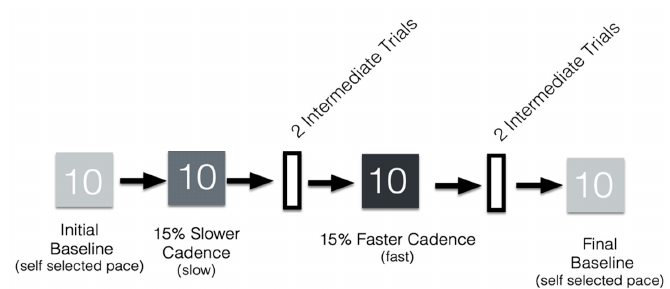
Figure 1. Metronome walking task procedure. The figure shows an example in which the slow metronome pace was played first. Light gray boxes represent initial and final baseline trials. Medium gray are slow metronome paces, and dark gray are fast metronome paces. After metronome trials at one pace were complete, participants walked for two intermediate trials at their own pace (white boxes).